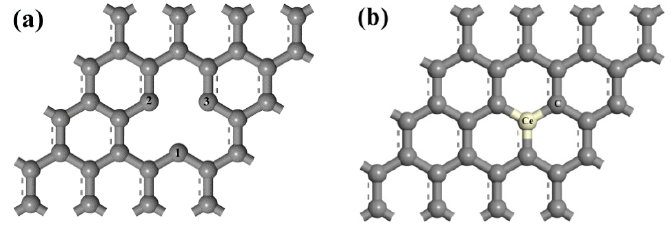
Figure 1. Physical models of graphene: ( a ) VG; ( b ) Ce-doped graphene.